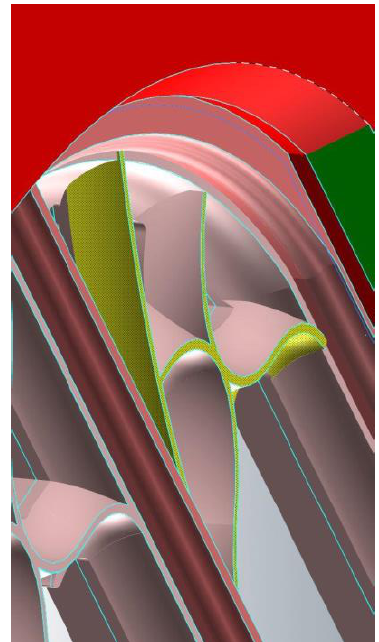
Figure 2: Detail of tracery in Rhino model.